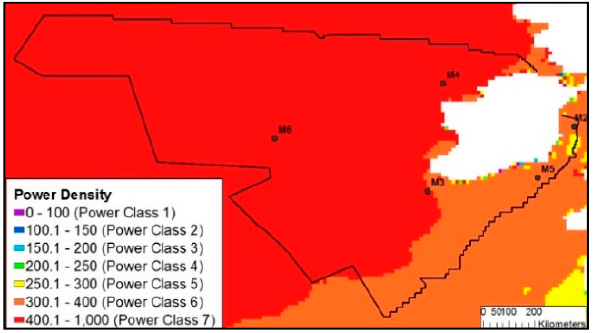
Figure 7. Energy density map (W m − 2 ) of Ireland’s offshore wind at 10 m above sea level derived from ASCAT-A and -B observations for the years 2013 to 2016 and ASCAT-A 2012.